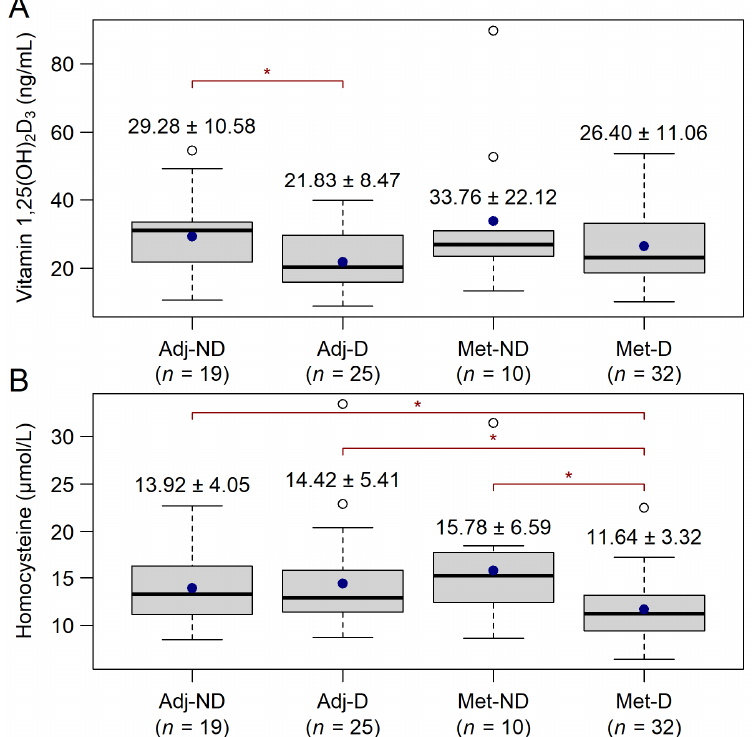
Figure 1. Baseline vitamin 1,25(OH) 2 D 3 ( A ) and homocysteine ( B ) level of study participants, prior to vitamin D 3 supplementation (mean ± SD). Without p -value correction, vitamin 1,25(OH) 2 D 3 level differed between the Adj-ND and Adj-D groups (crude p = 0.0220, pairwise Wilcoxon–Mann–Whitney U-test), while homocysteine of patients within the Met-D group was significantly lower than those within the other three groups (crude p -values: p = 0.0400 vs. Adj-ND, p = 0.0360 vs. Adj-D and p = 0.0470 vs. Met-ND, pairwise Wilcoxon–Mann–Whitney U-test). Adj-ND: patients without metastasis and no vitamin D 3 supplementation; Adj-D: patients without metastasis with vitamin D 3 supplementation; Met-ND: patients with metastasis and no vitamin D 3 supplementation; Met-D: patients with metastasis with vitamin D 3 supplementation. The hollow black circles, blue dot, and the thick line represent outliers (>1.5 times the interquartile range above the upper quartile), the mean and median value, respectively. * p < 0.05 .